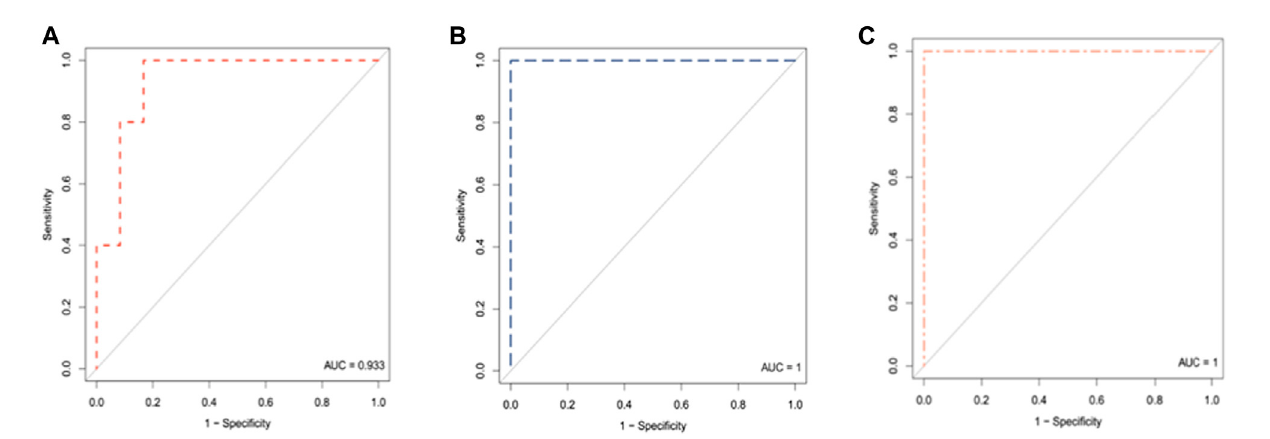
FIGURE 7 ROC curve analysis of CAIX (A) , sFlt1/PlGF ratio (B) , and CAIX/PlGF ratio (C) in women who did not develop the pathology ( n = 12) at a gestational age ranging from 28 to 32weeks compared to women with early overt PE ( n =